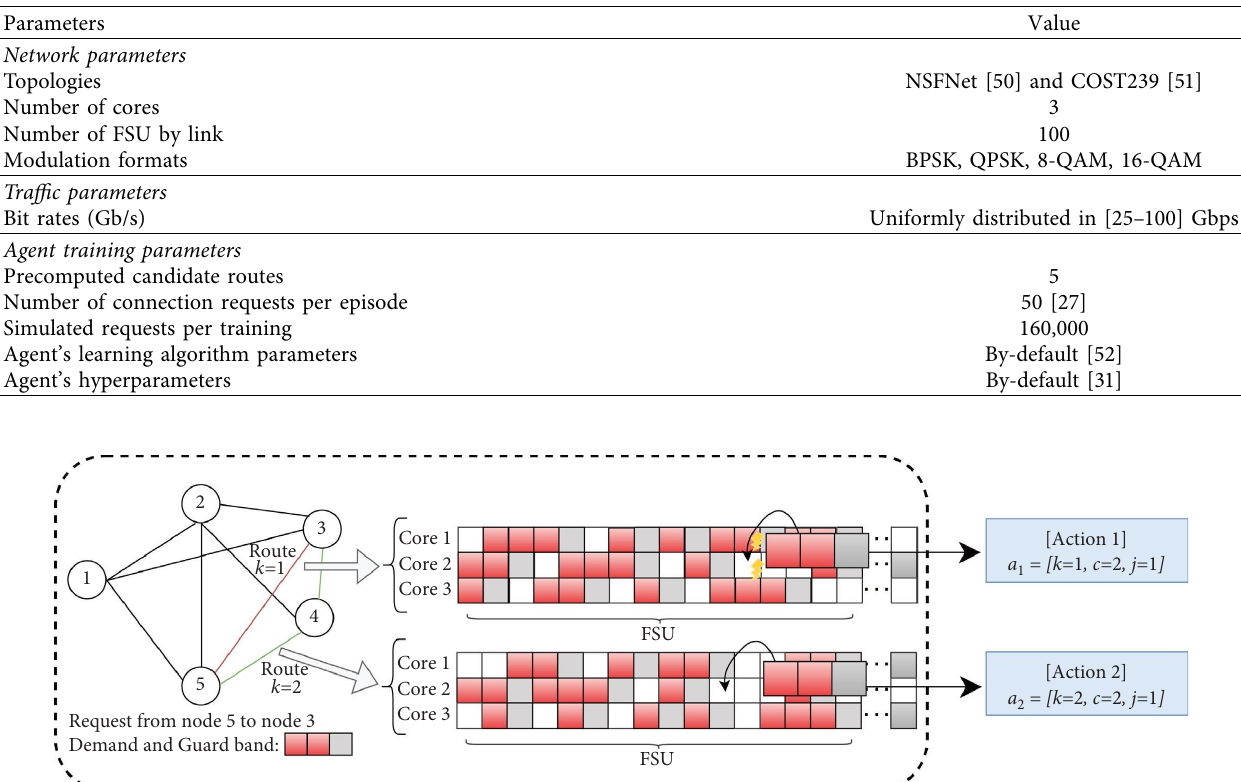
Table 3: Network, trafc and training parameters.